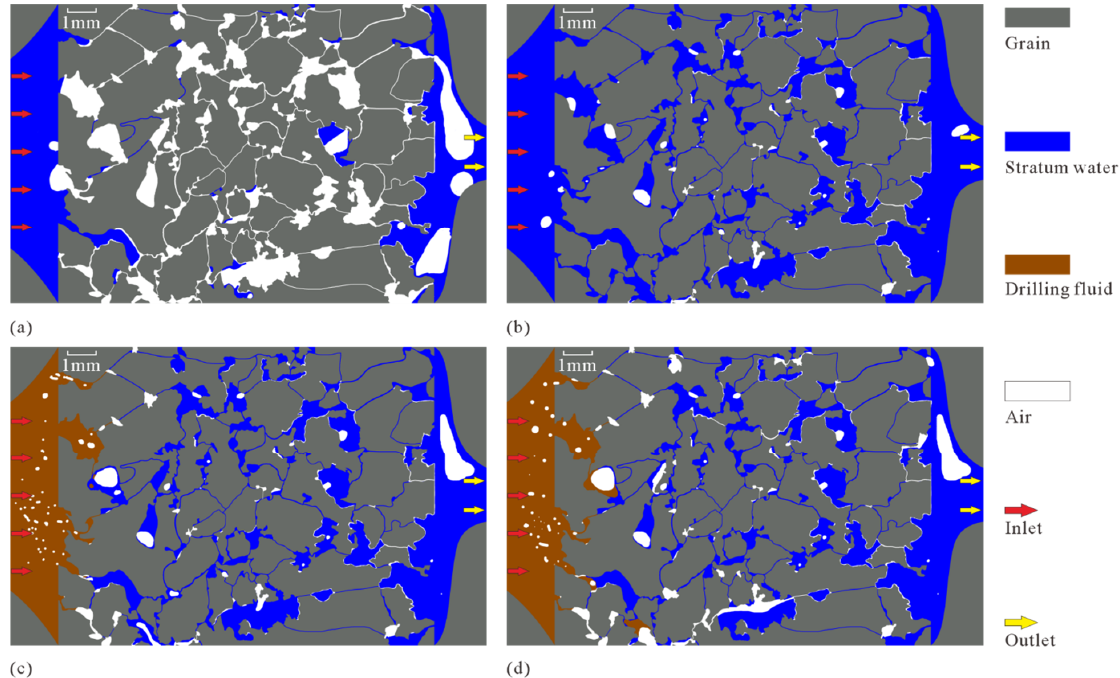
Figure 6. Image processing results of the damage of MEM by drilling fluid: ( a ) intermediate state of saturated stratum water in the microscopic model; ( b ) final state of saturated stratum water in the microscopic model; ( c ) intermediate state of drilling fluid displacing stratum fluid; ( d ) complete state of drilling fluid displacing stratum